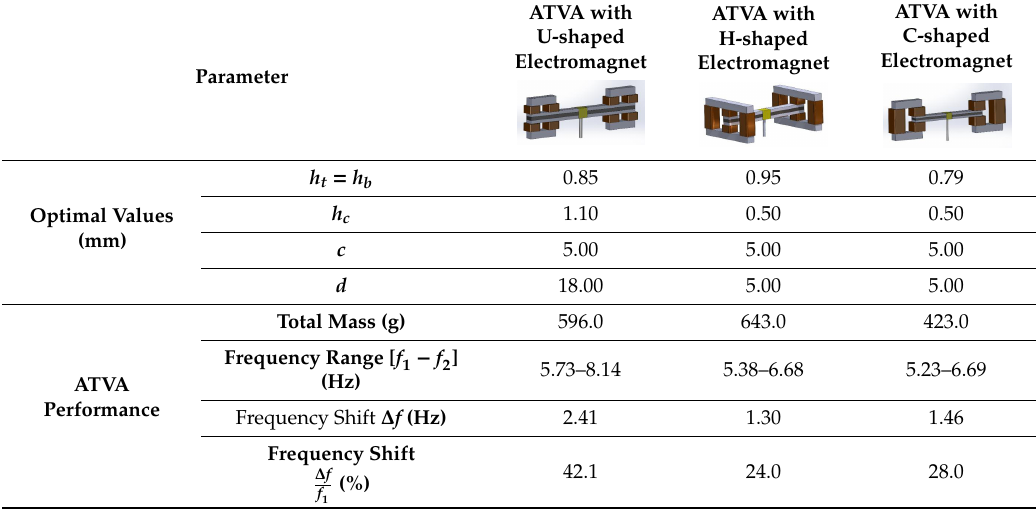
Table 2. Optimization results of the MRE-ATVA with the three di ff erent electromagnets. ATVA with U-shaped Parameter